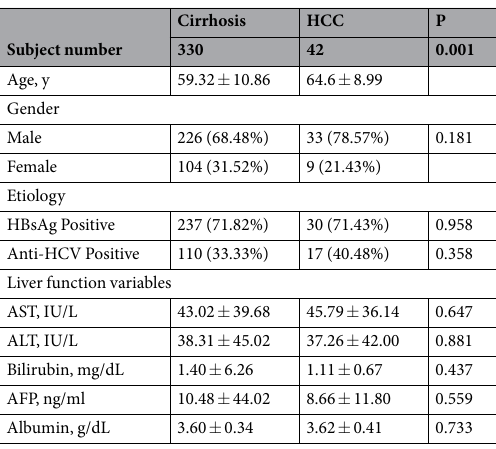
Table 1. Demographic information of the study